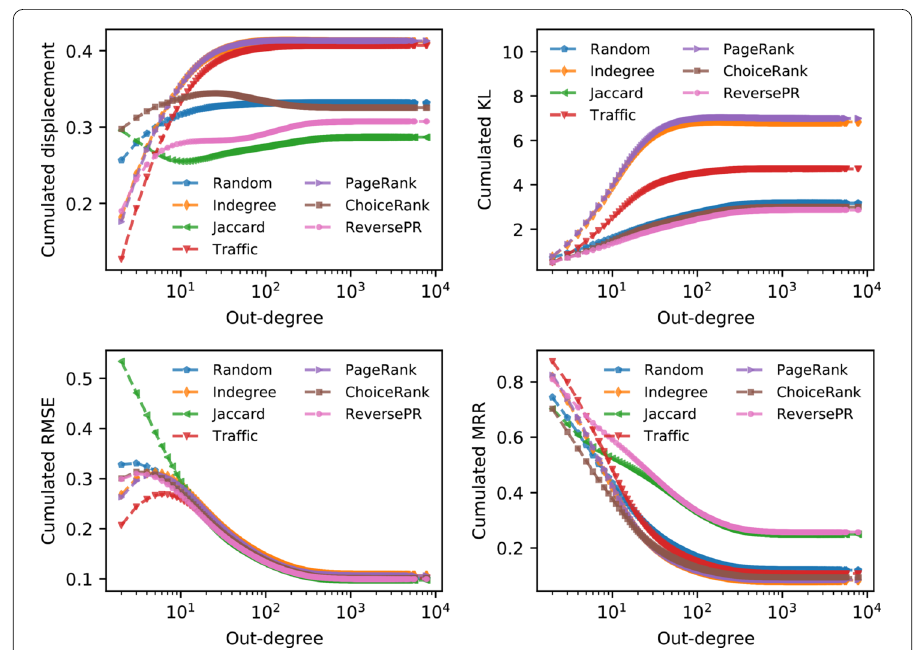
Figure 5 Cumulated evaluation metrics for the Wikipedia network. Scores are reported as a function of the outdegree of Wikipedia